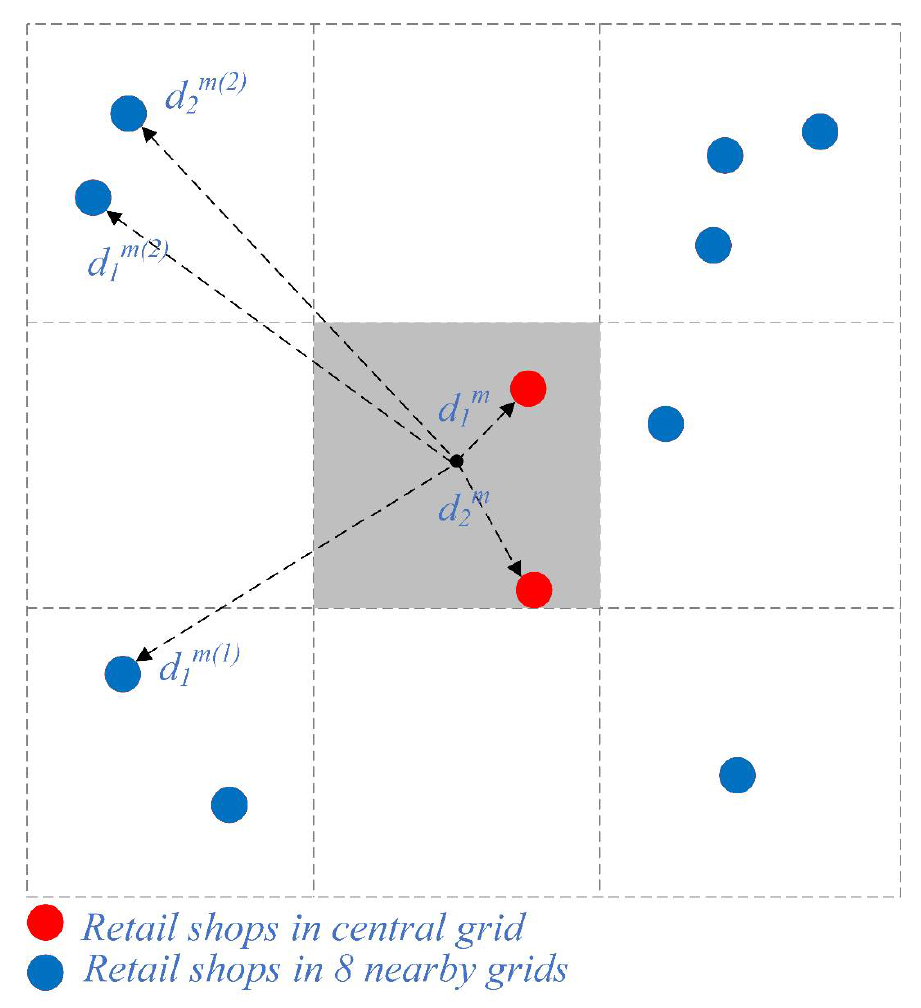
Figure 4. Spatial proximity of retail shops in the central grid and in eight nearby grids. Red points denote retail shops in central grid (gray background); blue points denote retail shops in nearby grids; d m denotes the distance of the central point to shop i , which is located in central grid; d m i denotes the distance of the central point to shop i , which is in one of the nearby grids m ( j )